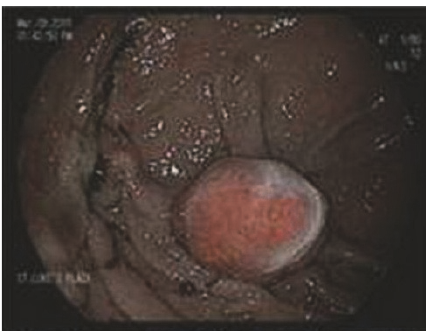
Figure 1: EGD showing a 2.5 to 3.0 cm polypoid mass in the gastric fundus.